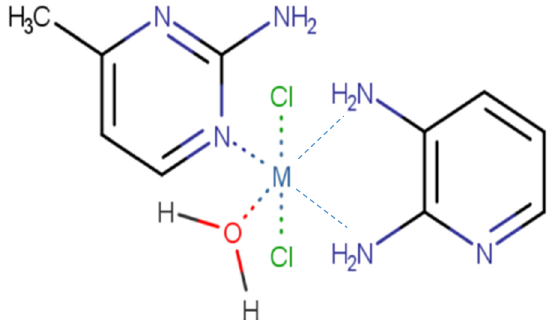
Figure 3. Structure of [M(AMPY)(DAPY)Cl 2 (H 2 O)] M = Co(II), Cu(II), and Zn(II).